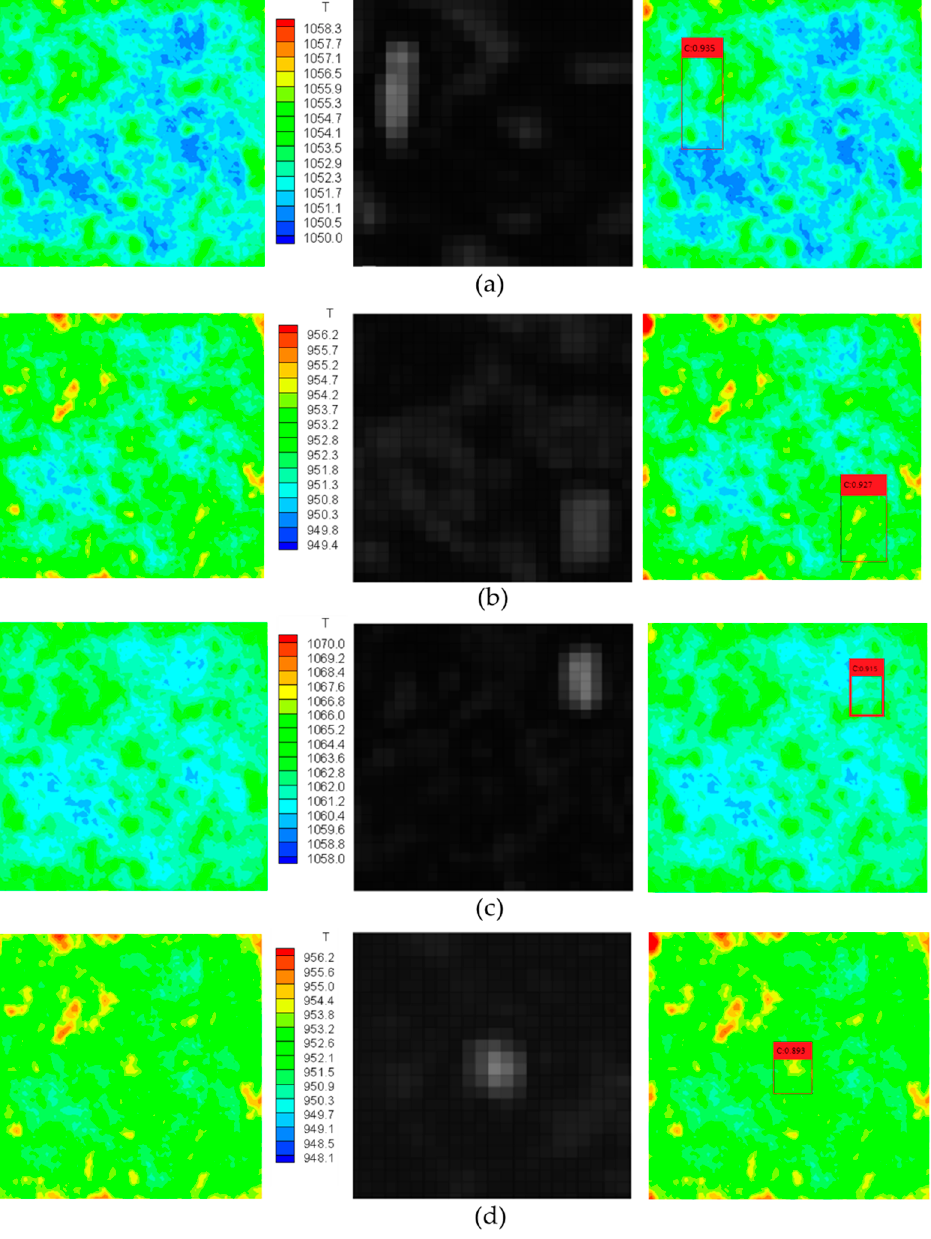
Figure 5. Examples of small scale crack detection results of using MSE-Faster R-CNN. ( a ) Porosity = 5%, Crack length = 40 µ m; ( b ) Porosity = 20%, Crack length = 30 µ m; ( c ) Porosity = 15%, Crack length = 20 µ m; ( d ) Porosity = 25%, Crack length = 10 µ m.